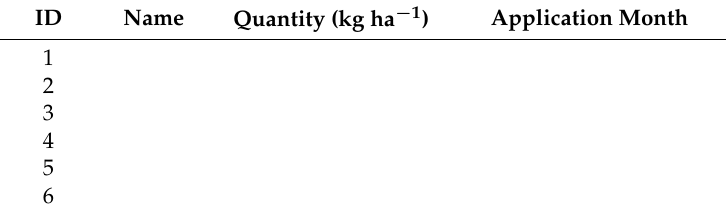
Table A2. Information on fertilization practices. Indicate the type and quantities of fertilizers generally